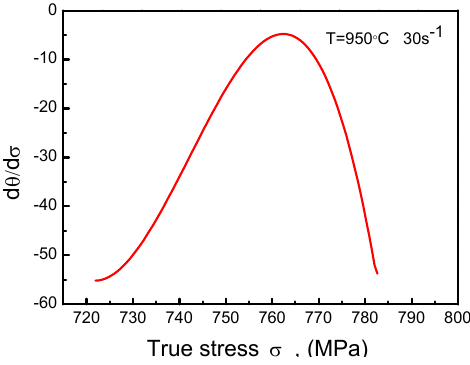
Figure 9. The plot of d θ /d σ ~ σ at 1223 K and 30 s − 1 .